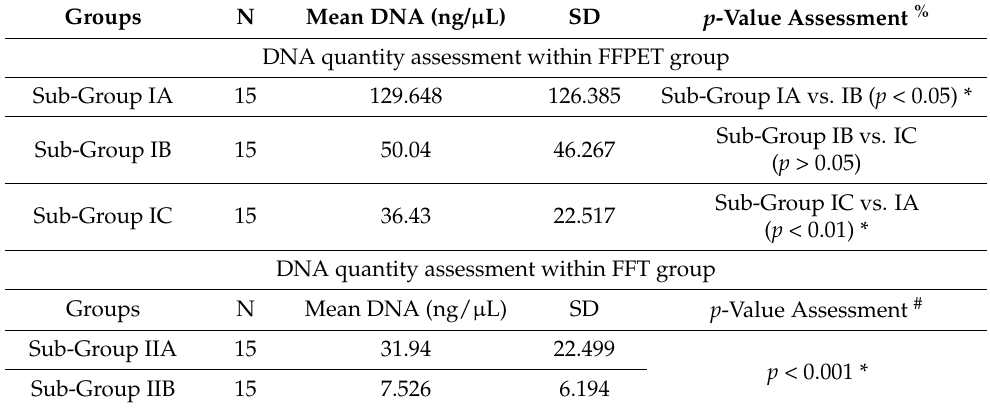
Table 5. Comparison of the mean DNA quantity within Group I (FFPET) and Group II (FFT).